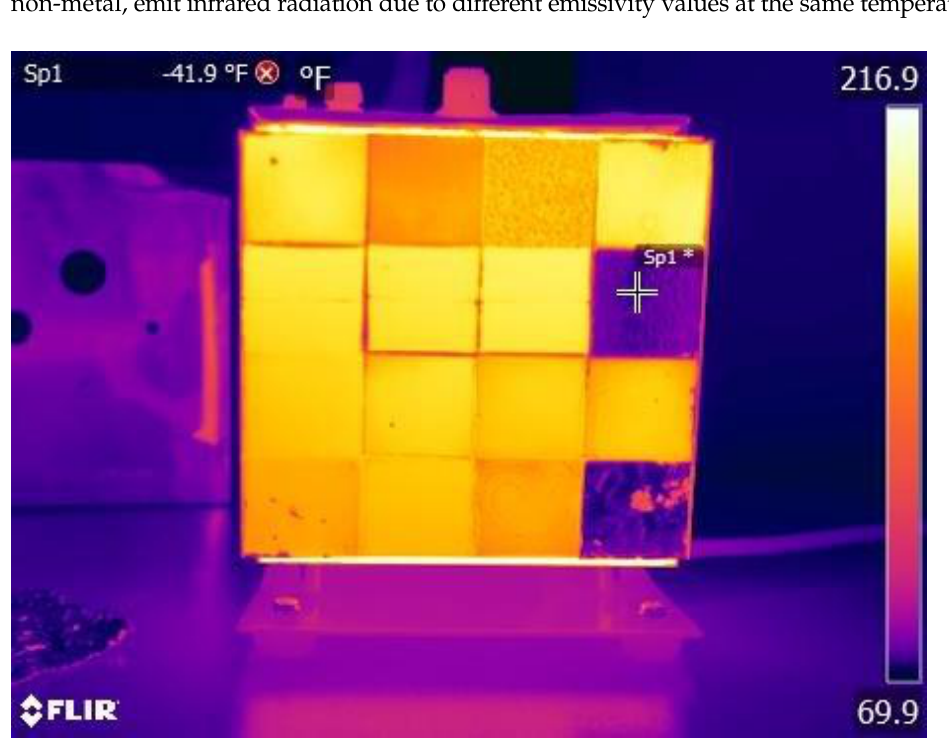
Figure 2. Sample of infrared radiation of different materials